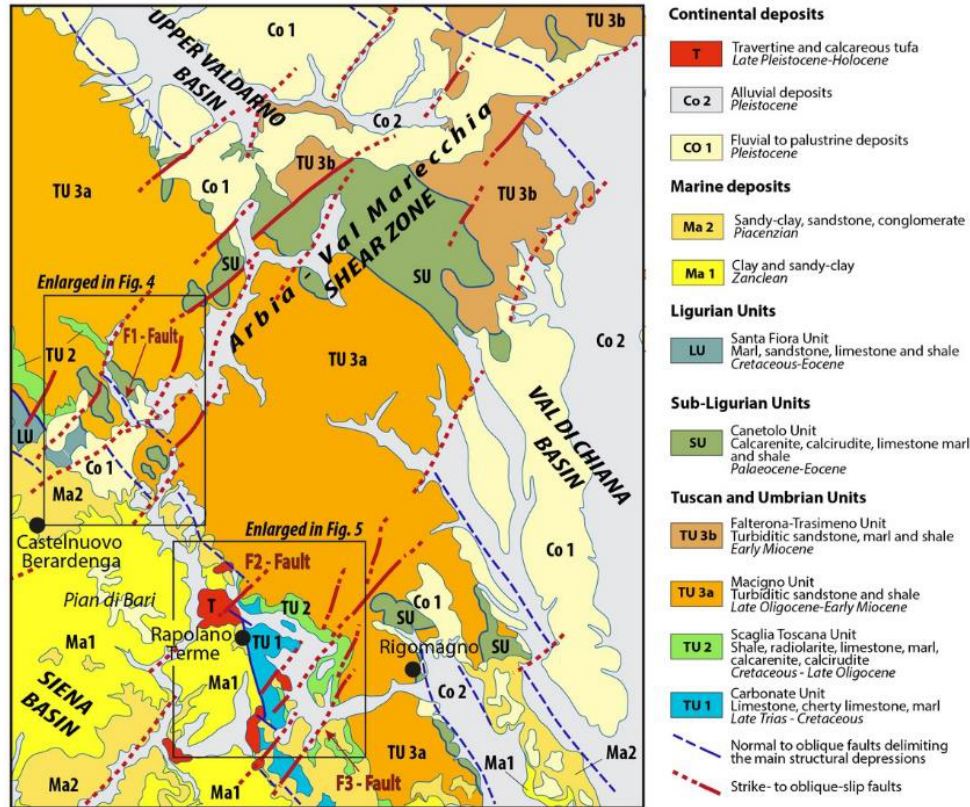
Figure 2. Geological map of the study area with indicated the enlarged areas in Figures 4 and 5. The indicated F1–F3 faults are mentioned in the text.